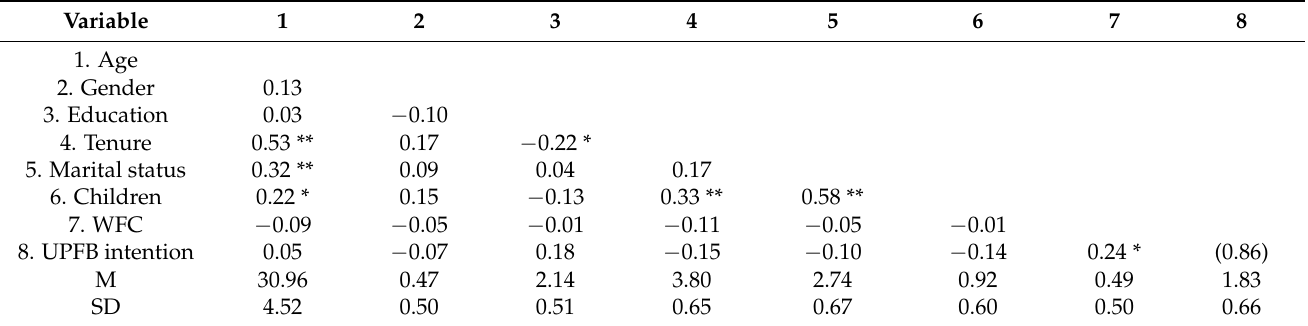
Table 1. Descriptive Statistics in Study